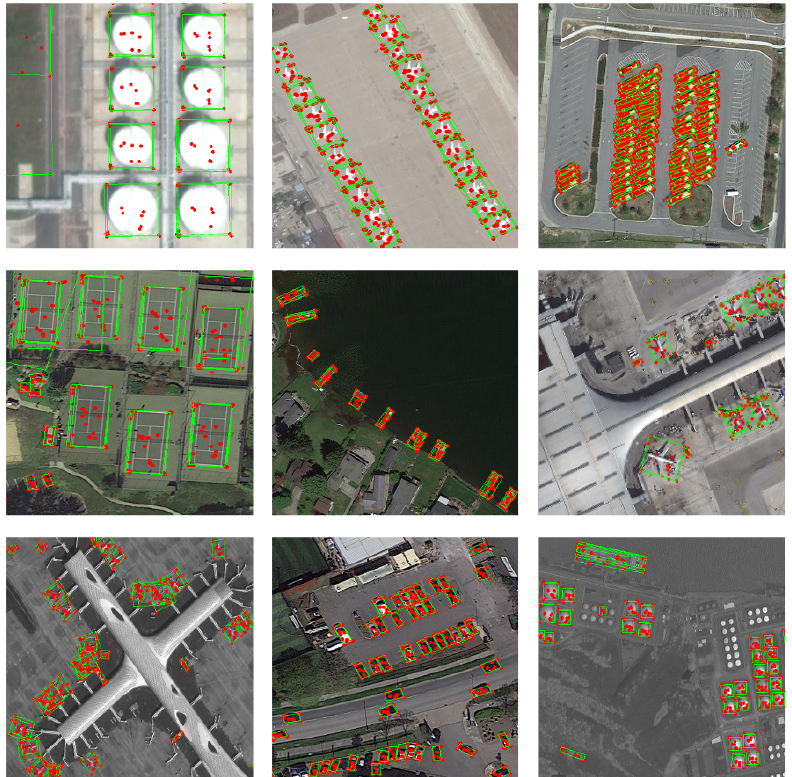
Figure 8. Visualization results of some examples of the learned representative points (red points) of PointRPN on the DOTA-v1.0 test set. The green oriented bounding boxes (OBBs) are the converted pseudo-OBBs via the MinAreaRect function of OpenCV. The score threshold was set to 0.001 without using